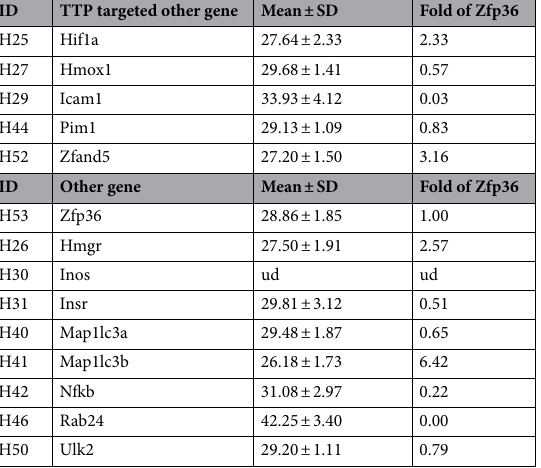
Table 4. Relative mRNA levels of respective gene families in the human colon cancer cells. The data represent the mean and standard deviation of 24 independent samples. ud: undetected. The relative mRNA levels were calculated using mean data of Bcl2 as the reference mRNA and the first mRNA in the respective gene family as the control.